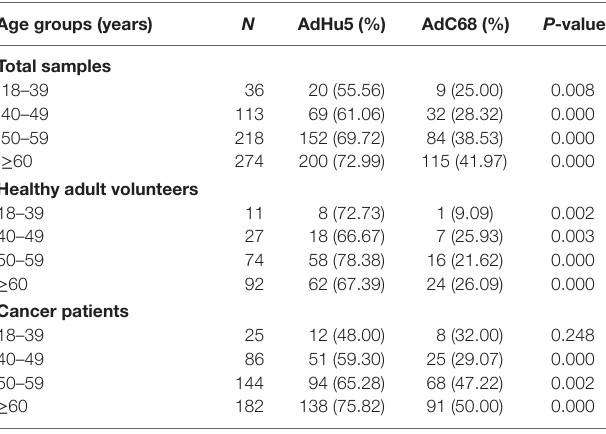
Table 8 | Titers of the AdHu5 and AdC68 neutralizing antibody in different age groups.